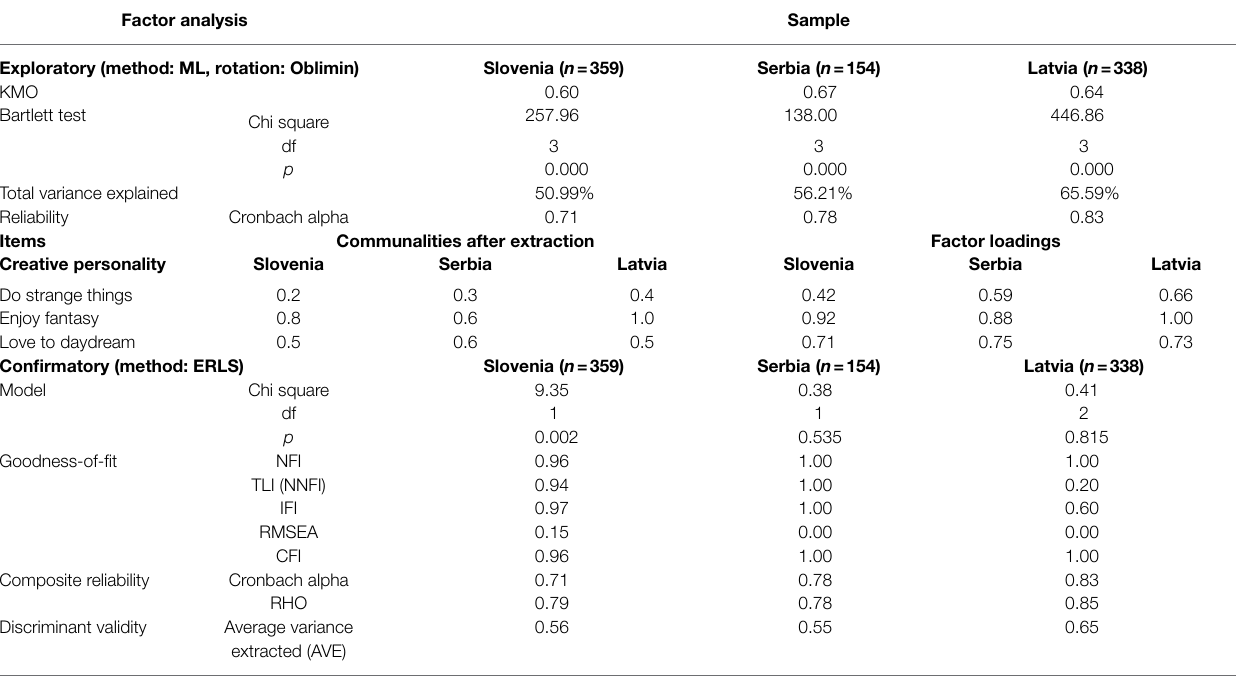
TABLE 4 | The creative personality construct—factor analysis results.